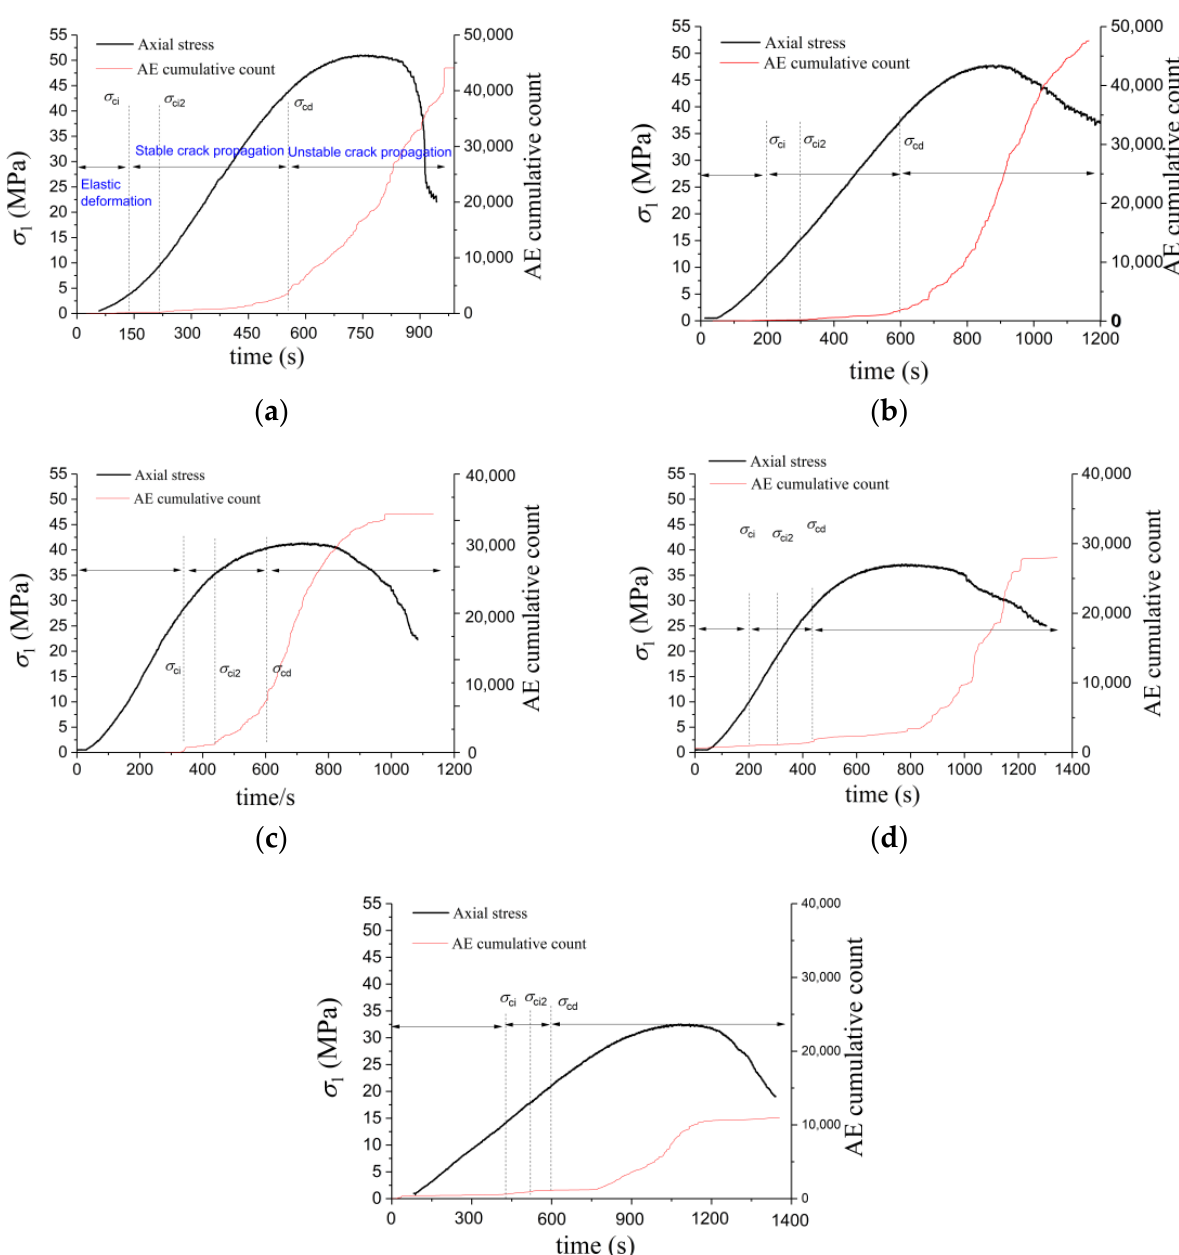
Figure 13. The stress-time-AE cumulative count curves of the gypsum rocks with the different water immersion durations, where σ ci , σ ci2 , and σ cd indicate the crack initiation stress, the secondary crack stress, and the crack damage stress: ( a ) Natural, ( b ) 1 day, ( c ) 7 days, ( d ) 15 days, and ( e ) 30 days.